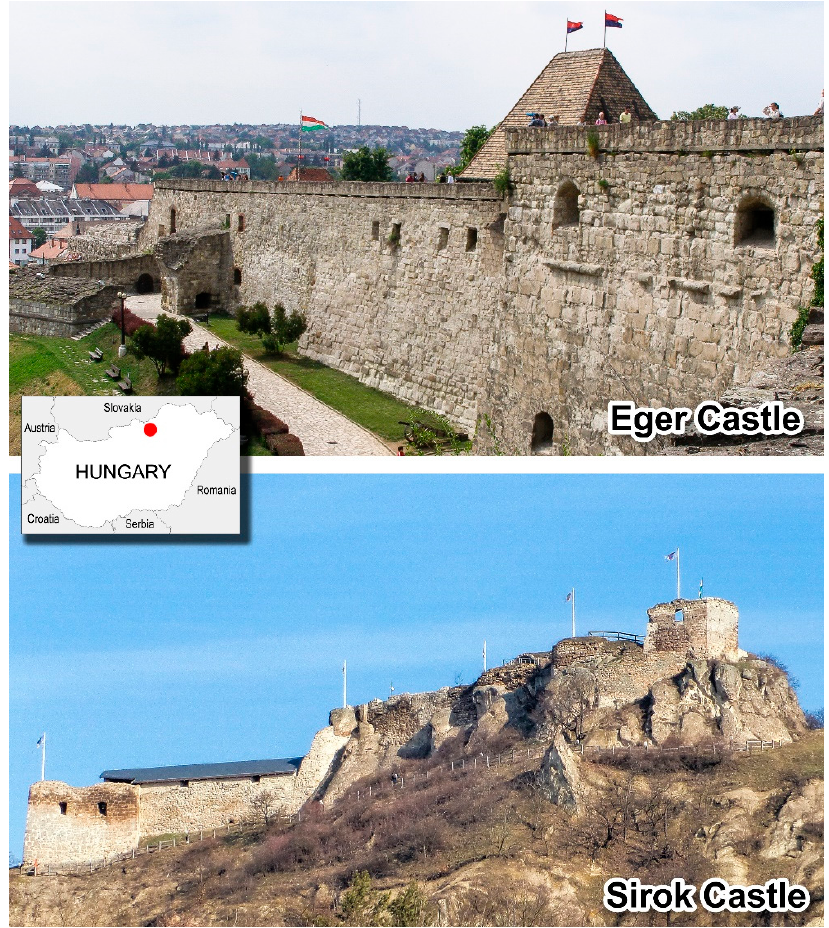
Figure 1. The medieval castles of Eger and Sirok in Northern Hungary.